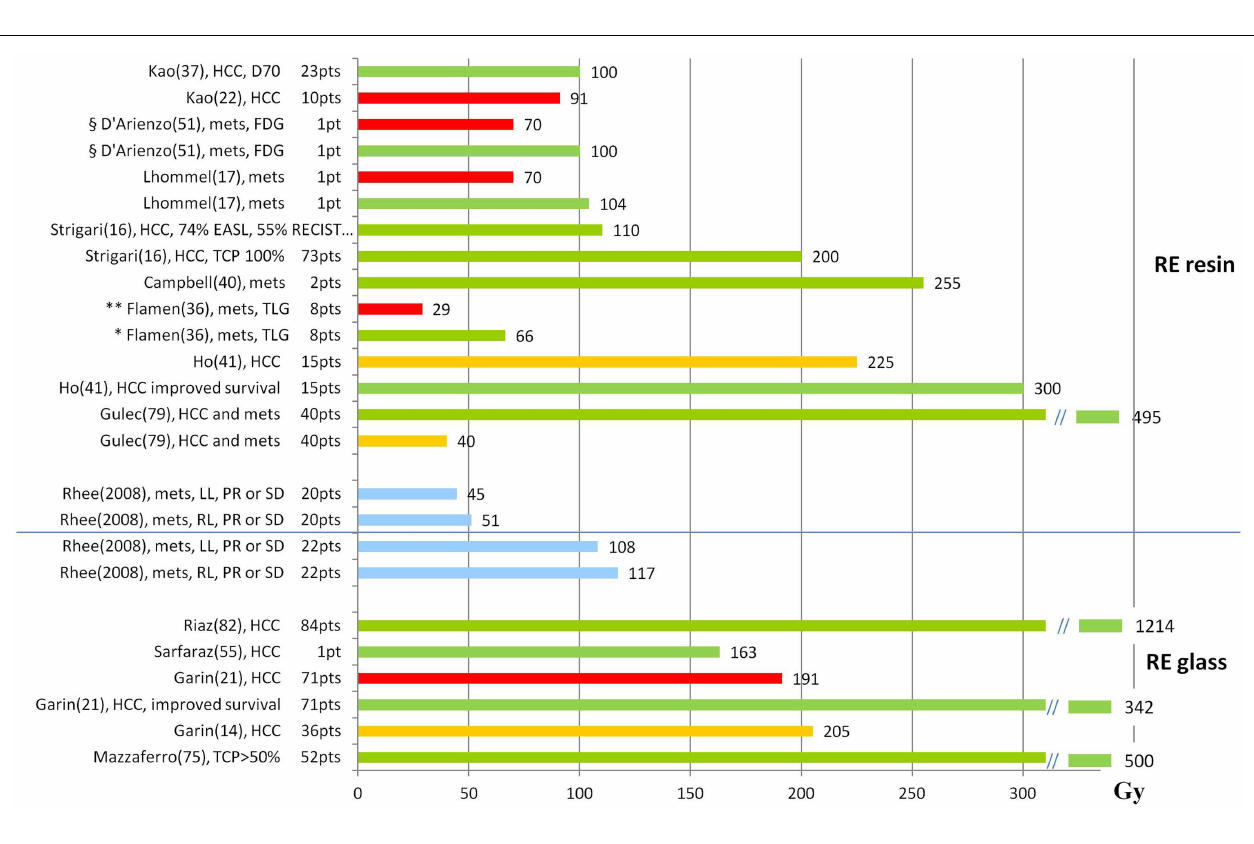
FIGURE 4 |Tumor absorbed doses (Gy) and response .The graph shows theT absorbed doses (Gy) reported in the literature, with information about the associated response. Red bars represent progression, orange bars represent the threshold for response, green bars observed response, and blue bars specifically indicate PR (partial response) or SD (stable